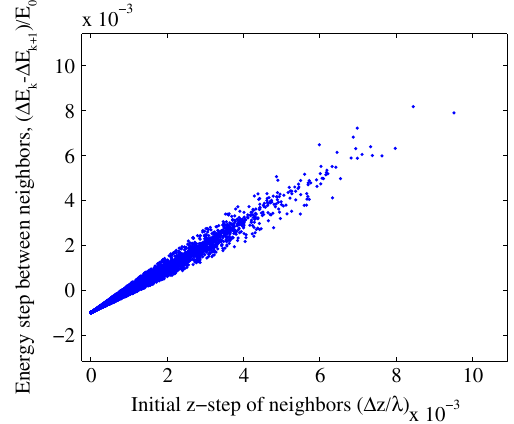
FIG. 11. The relative modulation between neighboring parti- (cid:1) E k , is proportional to the initial distance between cles, E k þ 1 the particles (sheets), (cid:5) z . Simulation is for the undulator inter- (cid:10) ¼ 10 3 . Particles that are closer (far- action, with (cid:2) ¼ 1 , n 0 0 , lose (gain) ther) than the interparticle spacing, (cid:5) z < 1 =n 0 energy relative to the previous particle, and move away (closer) in negative